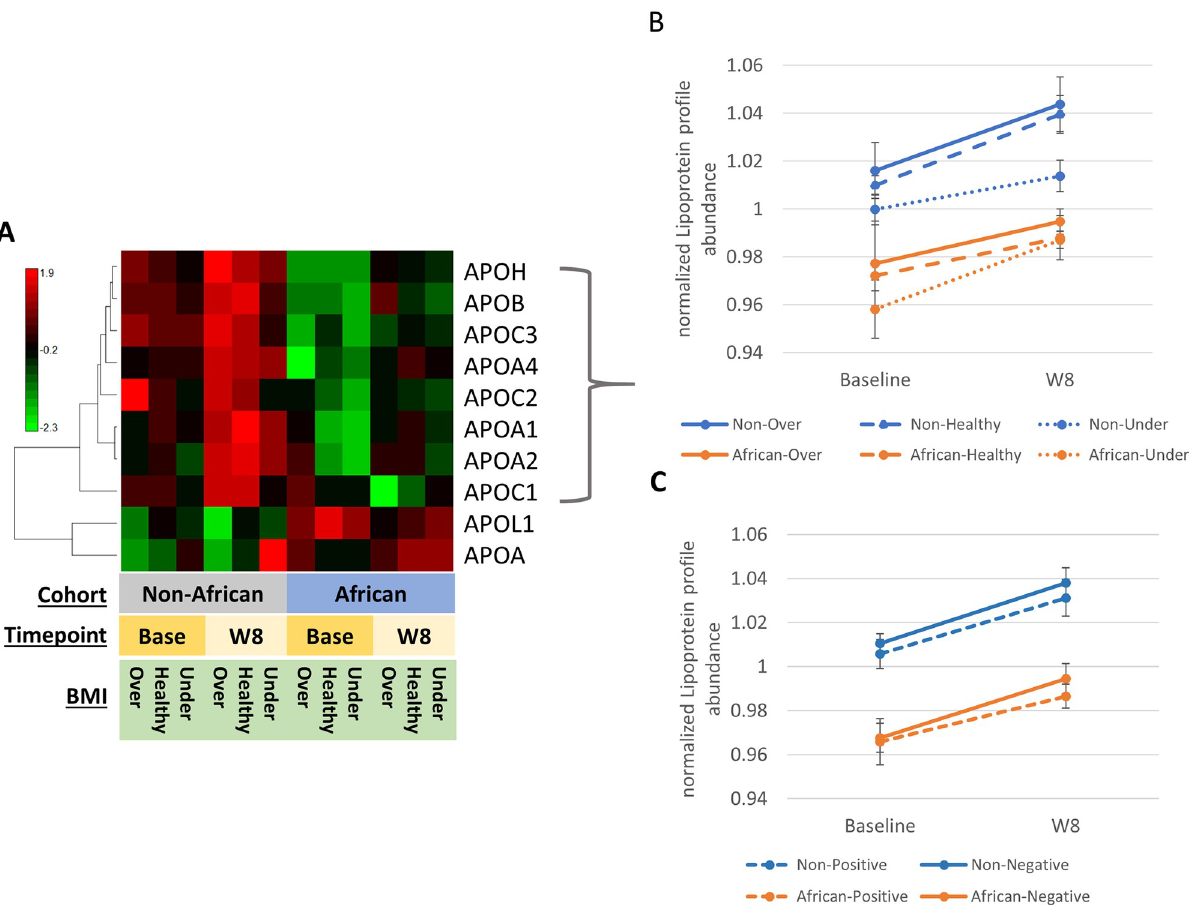
Fig 4. Comparison of apolipoprotein plasma signature with BMI and culture status. A) Heatmap, Pearson correlation, of all apolipoproteins encompassed within the African TB patient discriminatory protein signature stratified across cohort, timepoint, and BMI. Overweight > 25 BMI, Healthy weight between 18.5 and 24.9 BMI, Underweight, < 18.5 BMI. B) Graph of the apolipoprotein signature from the 8 proteins downregulated in the African cohort, stratified across BMI range. C) Graph of the apolipoprotein signature stratified across 8 week culture conversion status. B) and C) Values represent median protein abundances from a scaled normalization within each protein across time point and cohort. Error bars represent the standard deviation across the median protein values.